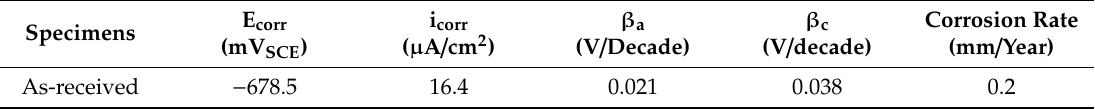
Table 4. Results of a potentiodynamic polarization test for the weldment specimen in a deaerated synthetic district heating water at 60 ◦ C and a pH of